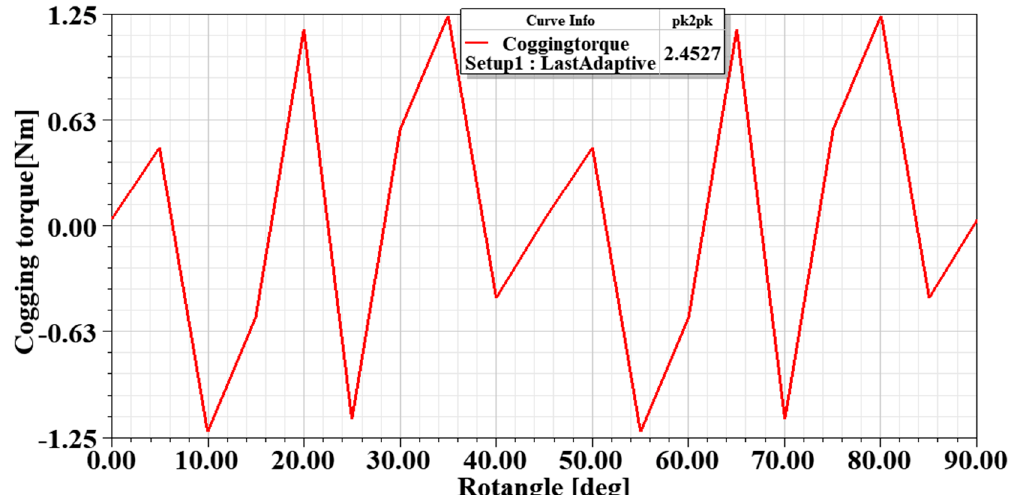
Figure 21. Cogging torque cycle under magneto-static no-load (MSNL).